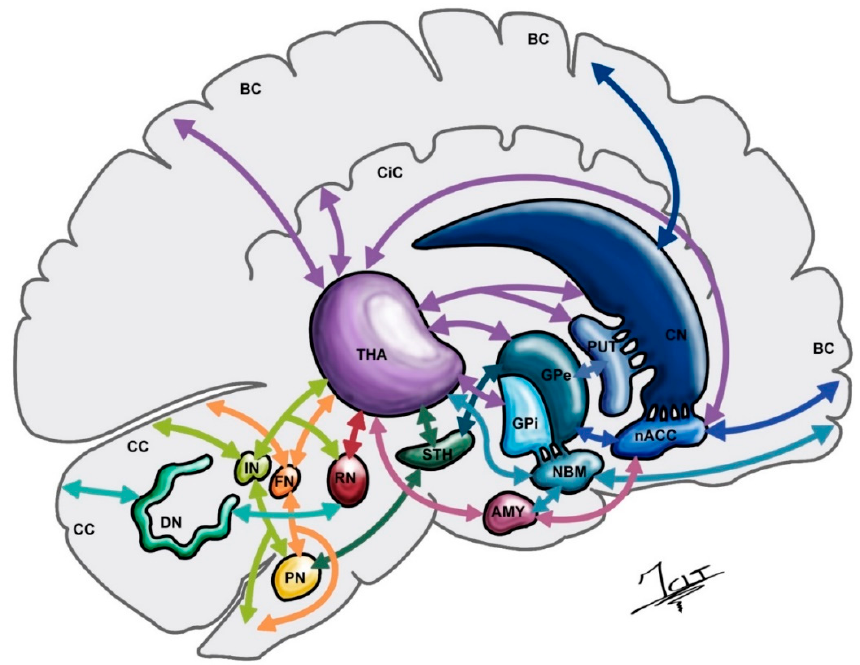
Figure 3. A sagittal section of the brain, trunk and cerebellum shows the complex connections between basal ganglia and cerebellum. AMY, Amygdala; BC, Brain cortex; CC, Cerebellar cortex; CiC, Cingulate cortex; CN, Caudate nucleus; DN, Dentate nucleus; FN, Fastigial nucleus; GPe, External globus pallidus; GPi, Internal globus pallidus; IN, Interpositus nucleus; NAcc, Nucleus accumbens; NBM, Nucleus basalis of Meynert; PN, Pontine nuclei; PUT, Putamen; RN, Red nucleus; STH, Subthalamus; THA, Thalamus. Illustrated by J. Lizana.